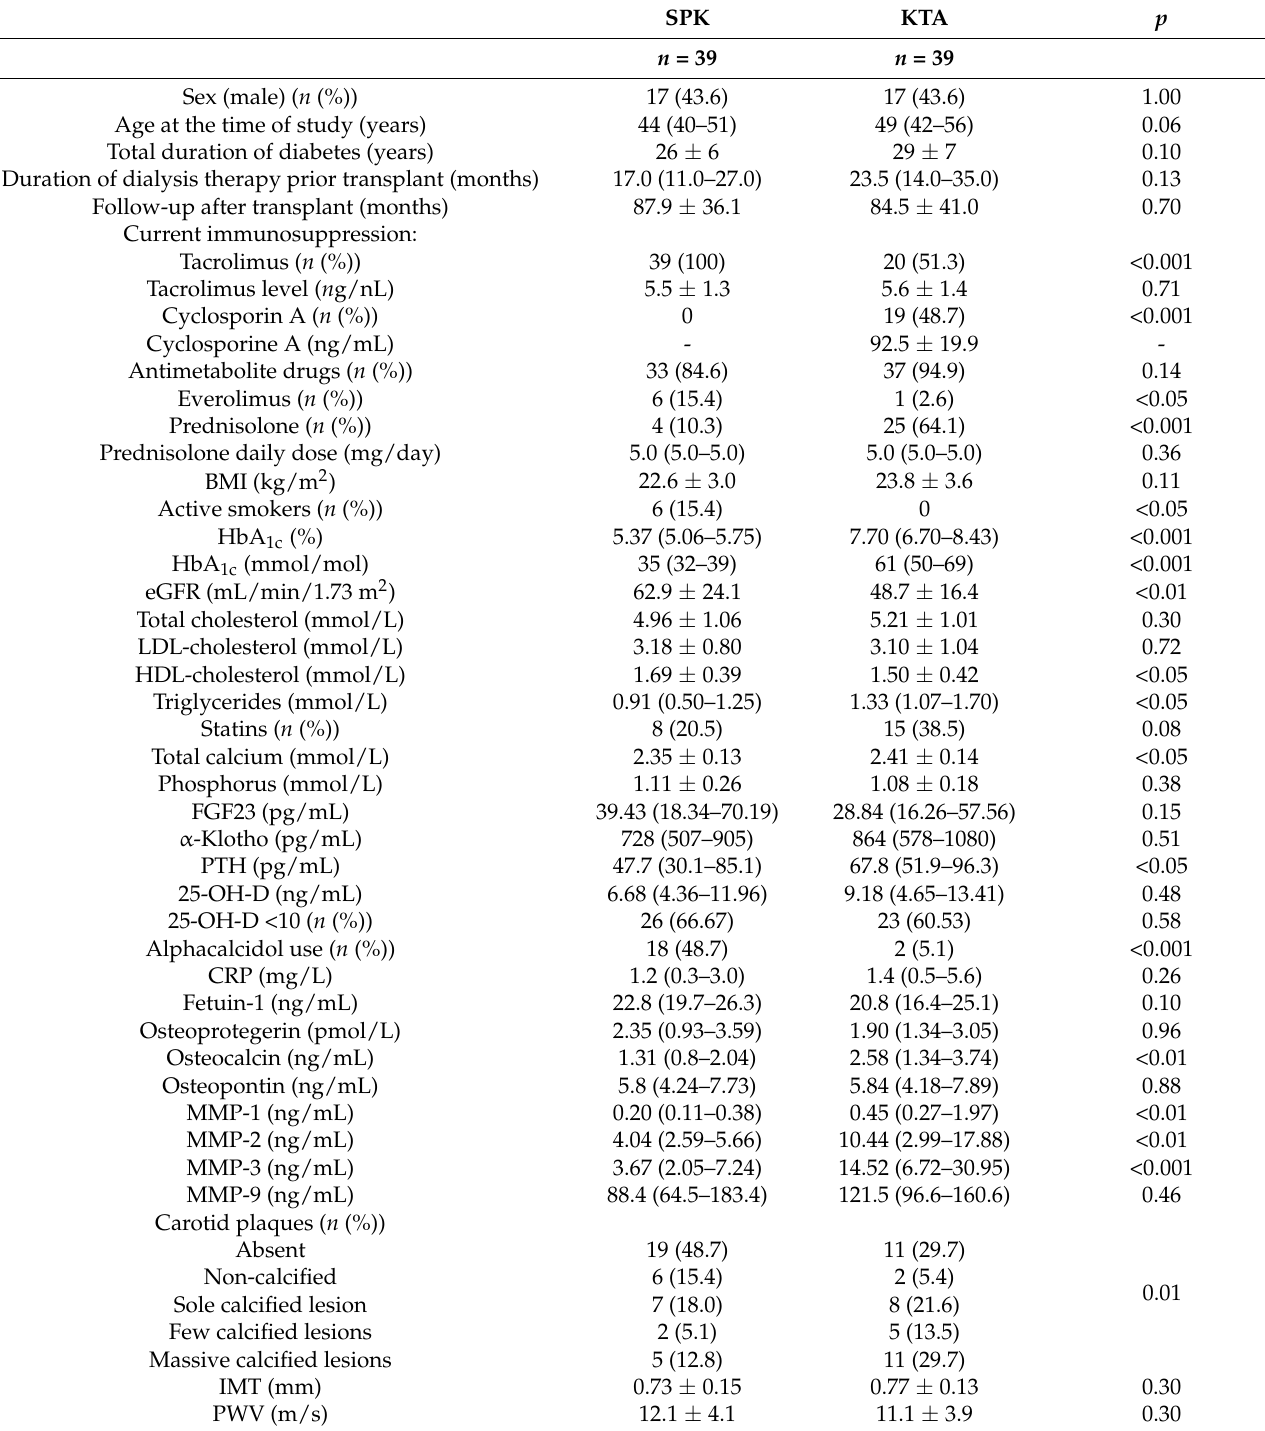
Table 1. Basic characteristics of both study groups (SPK and